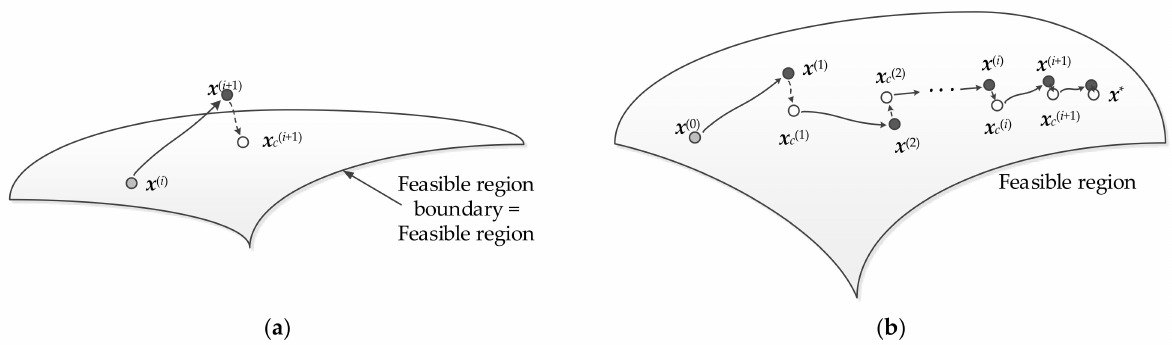
Figure 17. Optimization-based correction scheme for efficient control of equality constraints: ( a ) the concept: design x ( i +1) obtained in the i th iteration of the optimization algorithm, starting from x ( i ) , is infeasible; it is brought closer to a feasible space using the correction procedure [29], without neither degrading inequality constraints nor the circuit area; the corrected design x c ( i +1) features reduced equality constraint values S eq.k ( x c ( i +1) ) < S eq.k ( x ( i +1) ), k = 1, . . . , n eq , as well as A ( x c ( i +1) ) ≤ A ( x ( i +1) ),